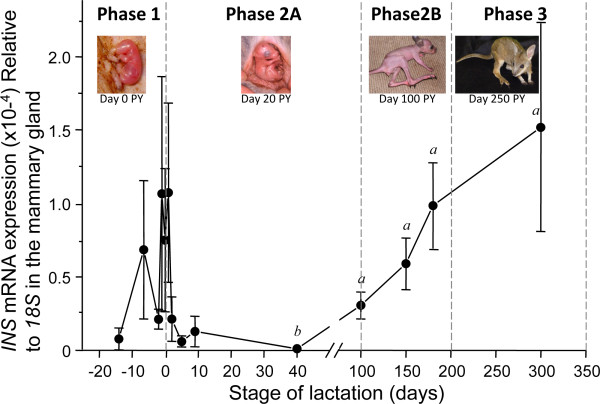
 INSmRNA expression relative to18SmRNA expression in the mammary gland.INS mRNA expression (mean ± standard error of the mean × 10-4) compared with18S expression in the mammary gland across the four phases of lactation. After birth, INS remained low until after 100 days of lactation.a significantly higher than b (P < 0.05). INS, insulin gene.